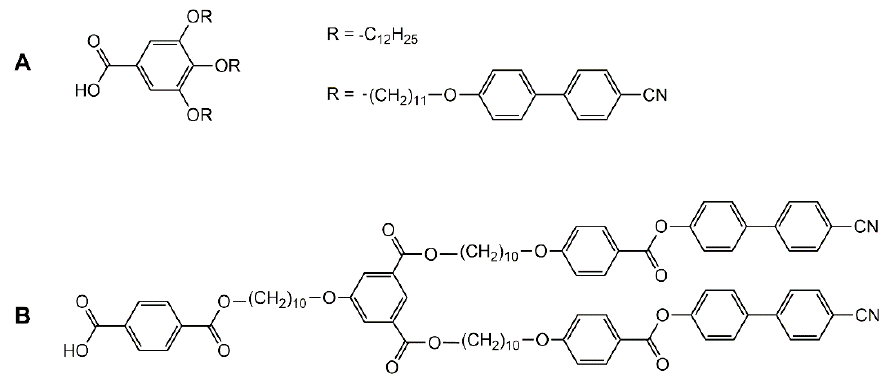
Figure 5. Functionalized carboxylic acid derivatives grafted to manganese ( A ) and ruthenium ( B ) metallic-cores [30,31].